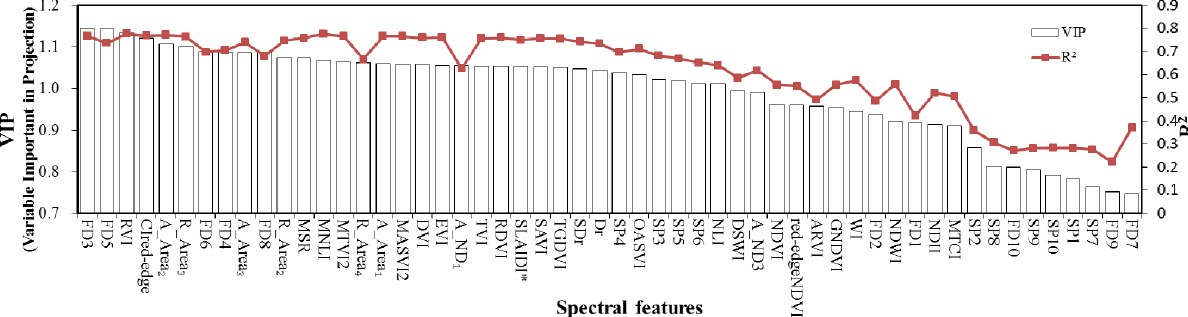
Figure 3. Variable importance in projection (VIP) and R 2 for each spectral feature.